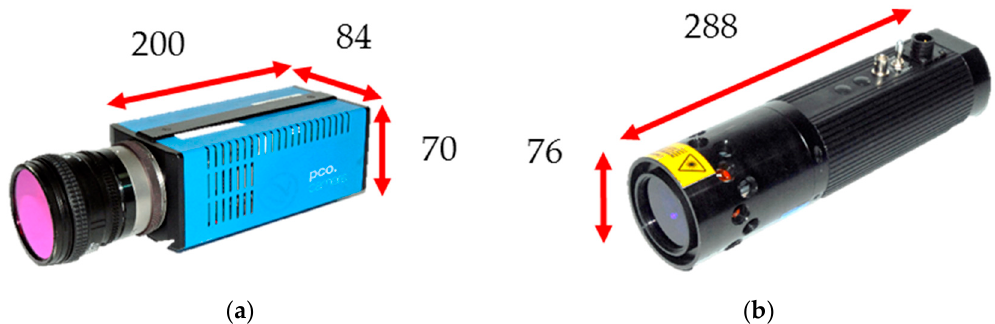
Figure 1. Typical PSP system components. All dimensions are in mm. ( a ) PCO.1600 camera; note that the dimensions do not include the lens; and ( b ) a high-power UV LED lamp from Innovative Scientific Solutions Incorporated.